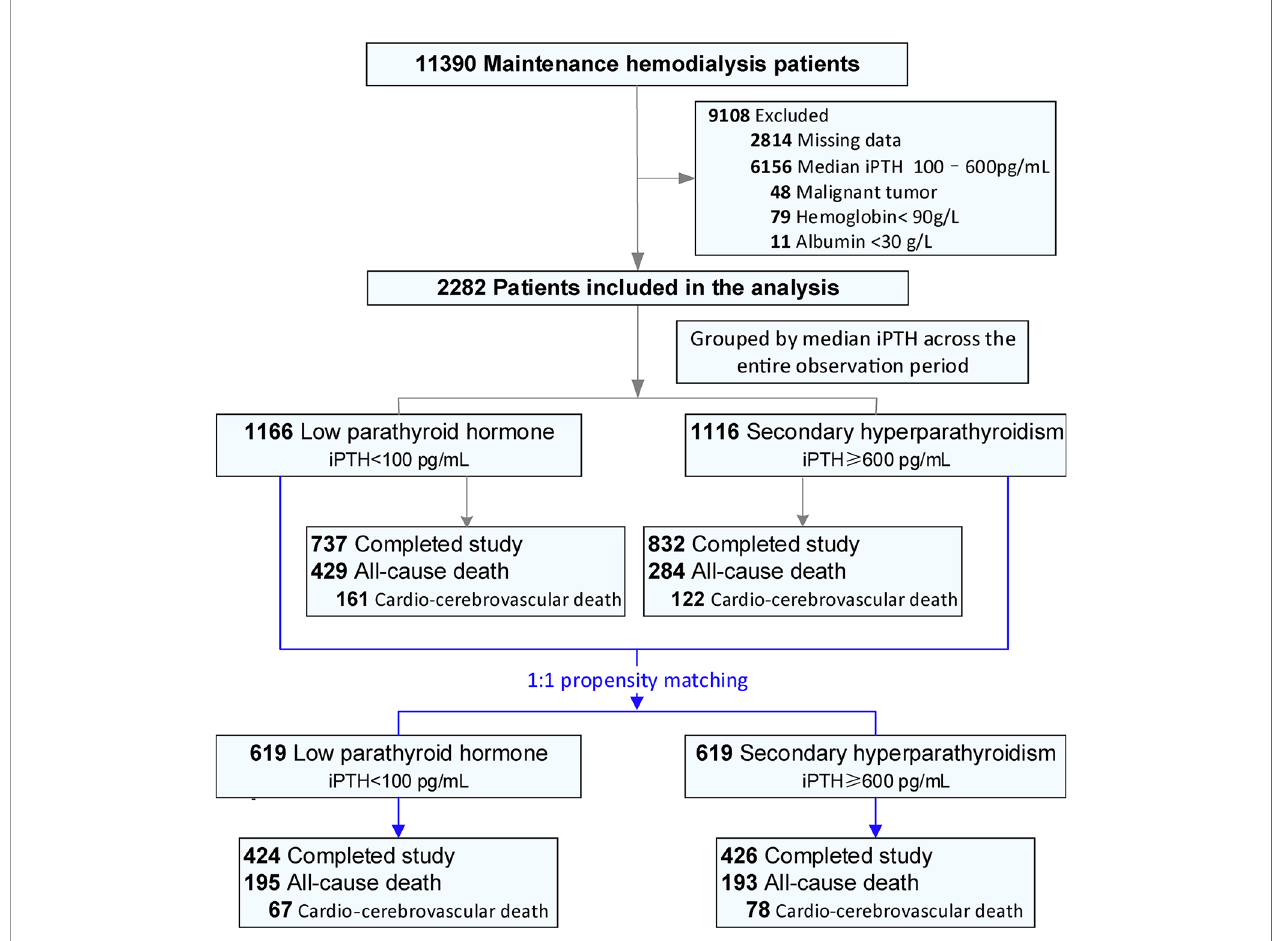
FIGURE 1 | Flow diagram of the